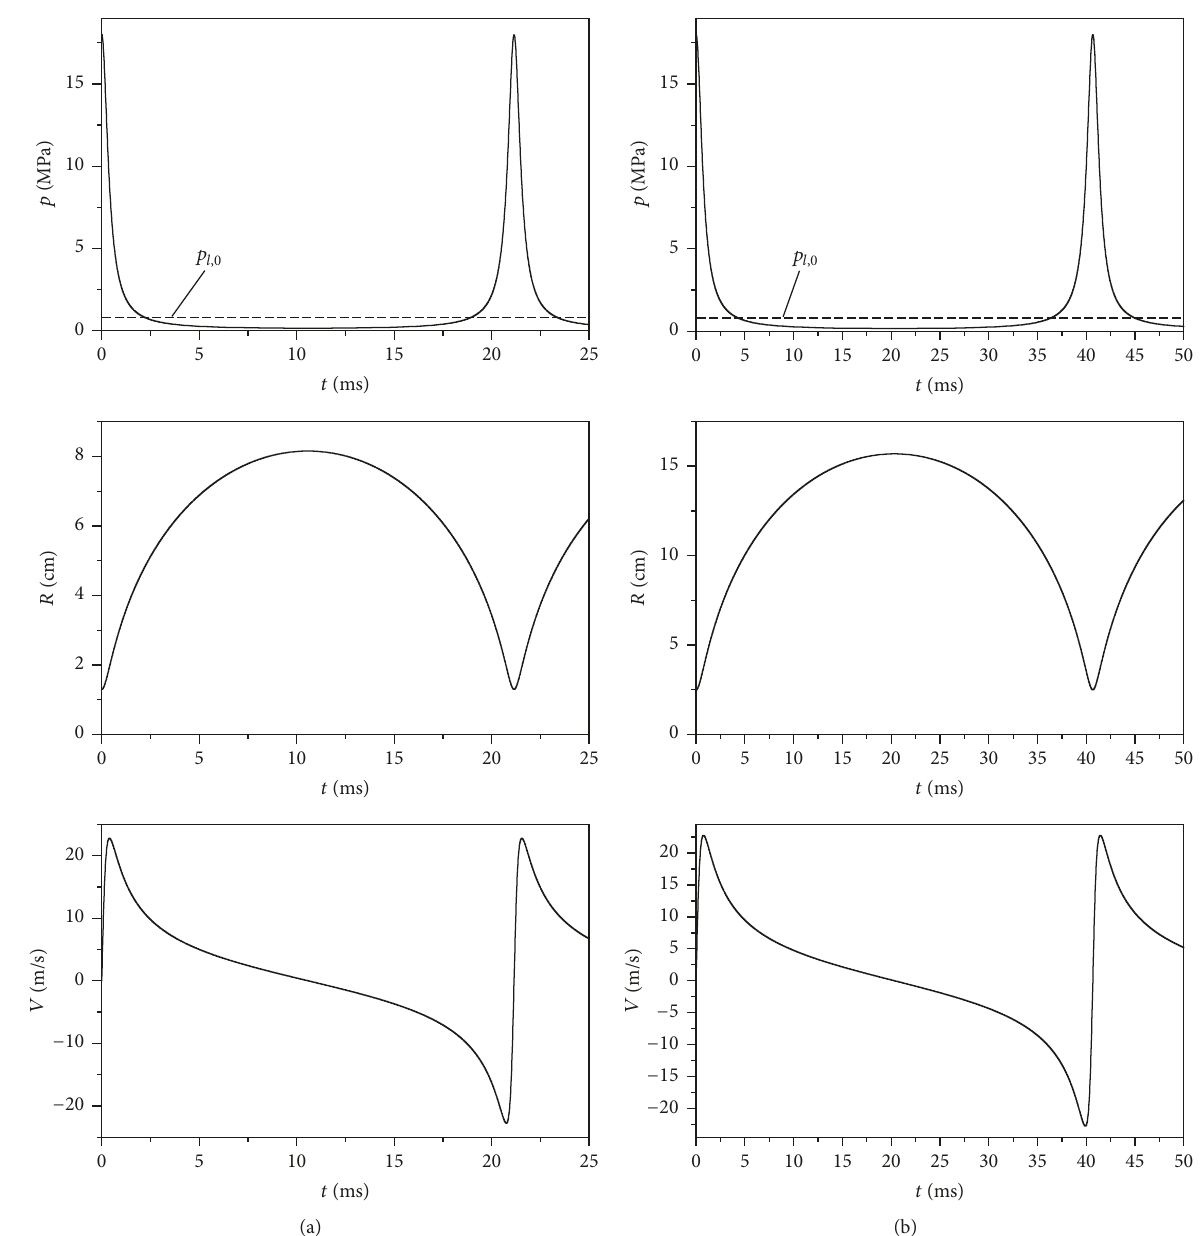
Figure 8: Time histories of water droplet pressure, radius, and expansion velocity upon oscillations in liquid lead for different initial radii: (a) 𝑅 = 13 mm; (b) 𝑅 = 25